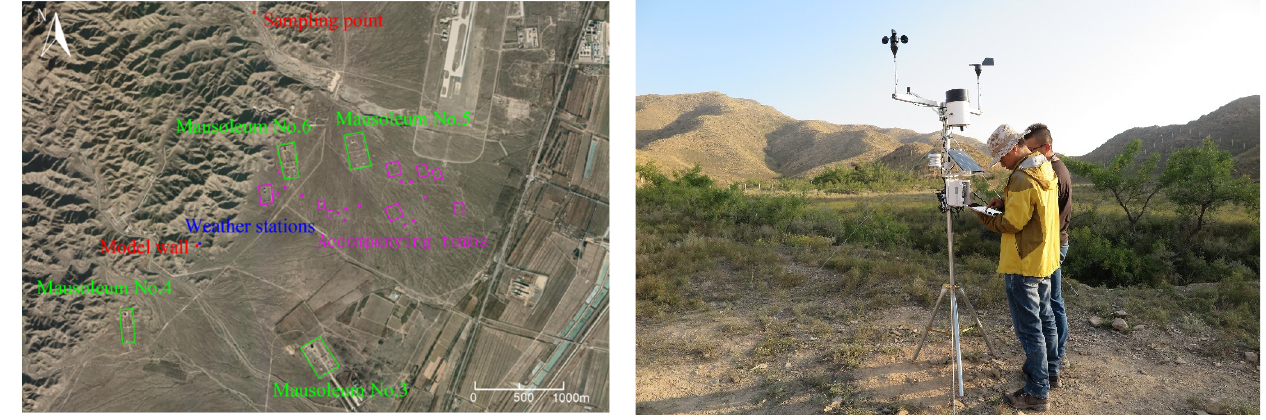
Figure 4. Meteorological station.